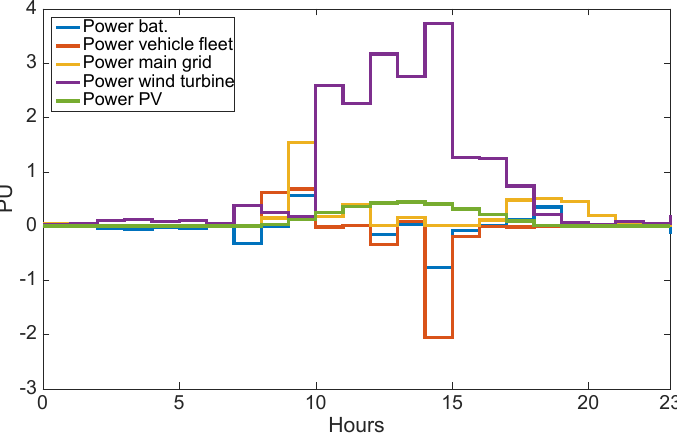
Figure 11. Result of the power in generators for a clear winter day.